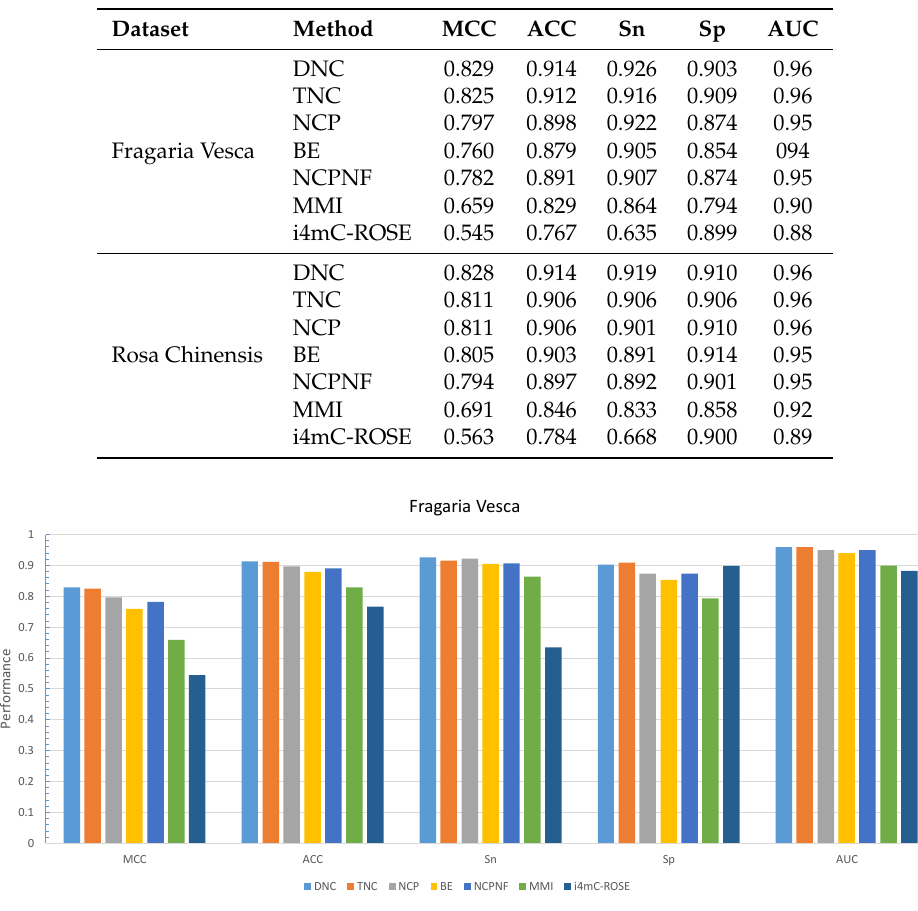
Figure 2. Grapical demonstration of performance comparison between six encoding methods and state-of-the-art model on training Fragaria Vesca